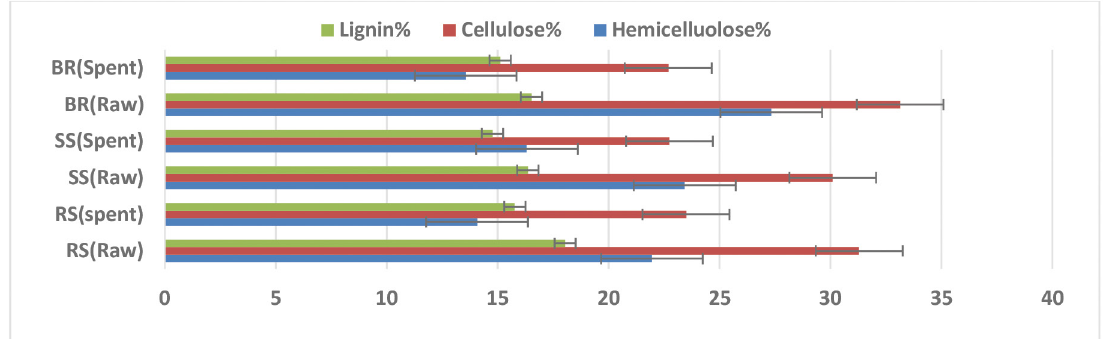
Fig. 7 Hemicellulose, cellulose, and lignin % alteration in substrate materials (RS, SS, and BR) before and after oyster mushroom cultivation RS=rice straw, SS= sorghum stalks, BR= banana residues; lines above the columns refer to standard error values (SE); n =